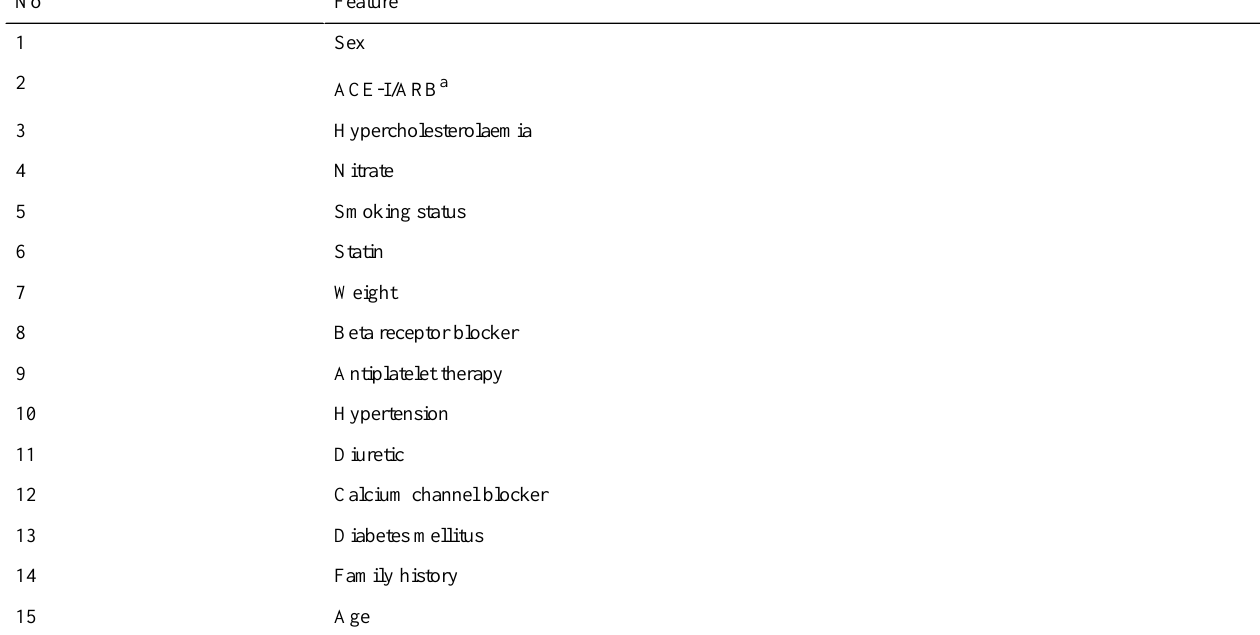
Table 4. Feature ranking in the model for patients with no prior ischemic heart